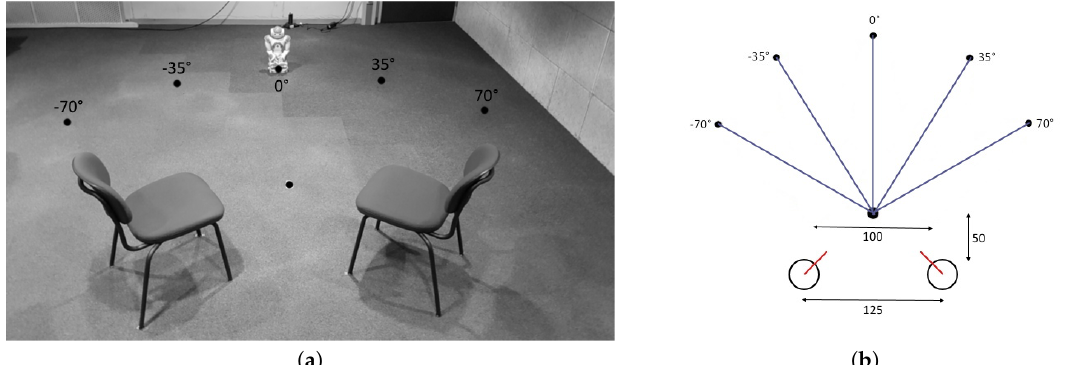
Figure 4. This figure shows ( a ) a picture and ( b ) a schematic overview of the setup in the lab for study 2. The two chairs are placed in an L-shape formation. The starting points of the robot are indicated with black dots on the circular plane around the chairs. The target location of the robot is indicated with the black dots between the